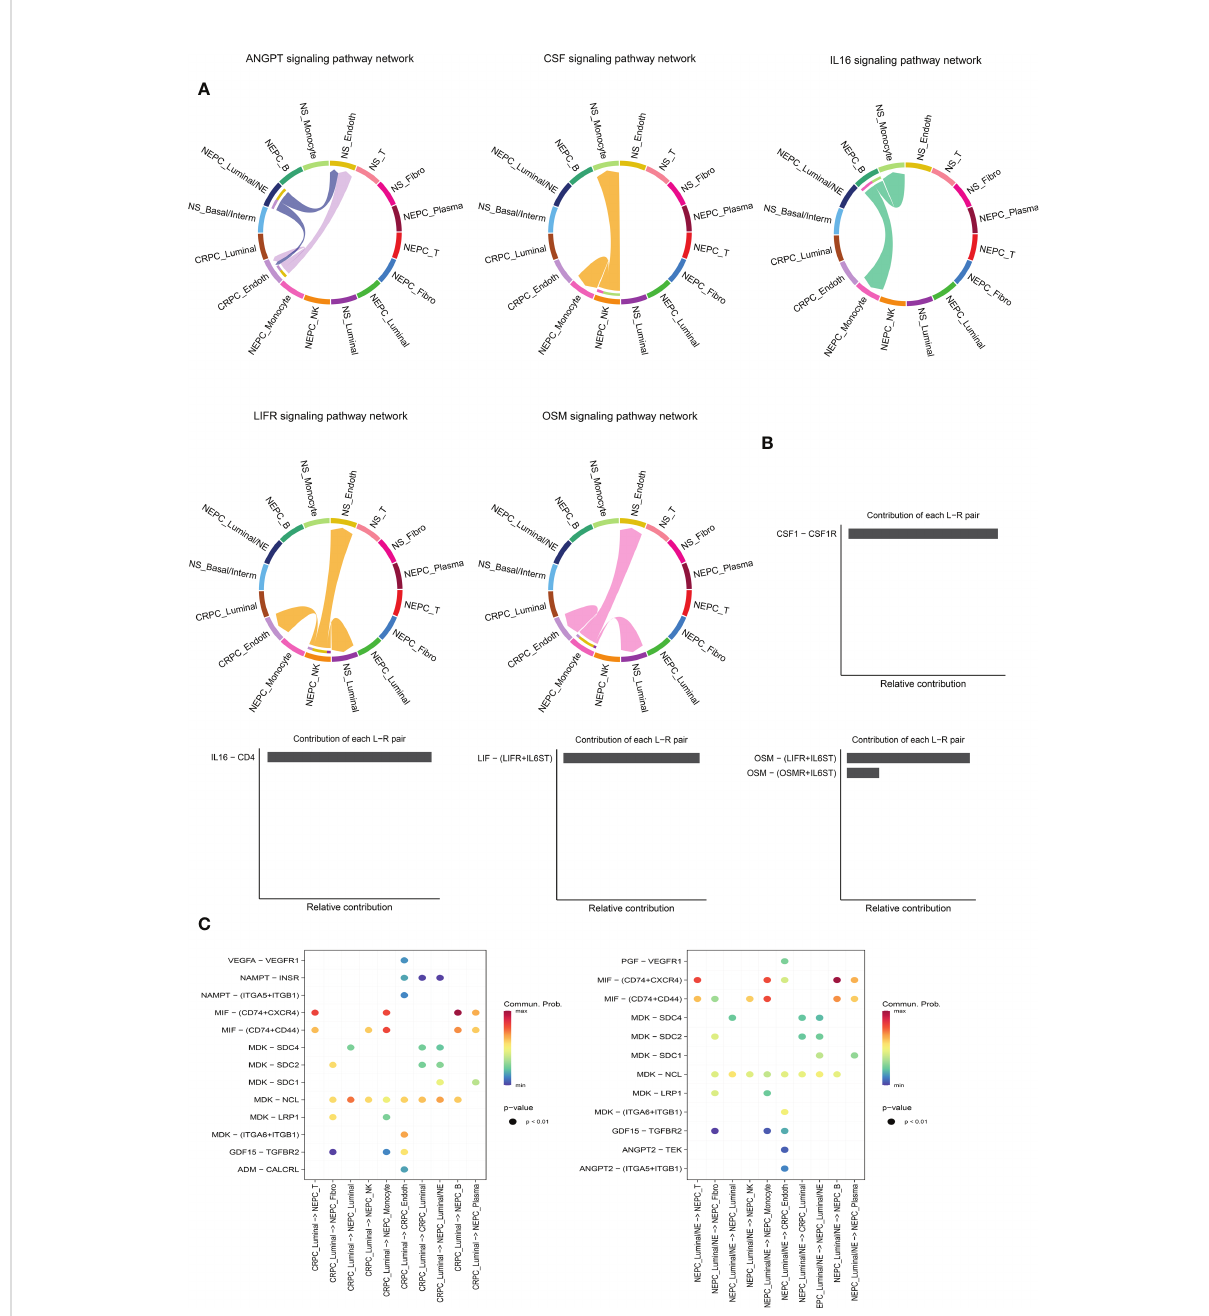
FIGURE 6 Intercellular ligand – receptor prediction among differernt clusters. (A) The chord diagram shows the expression of ANGTP, IL16, CSF, LIFR and OSM pathways among different cell clusters. In the peripheral ring, different colors represent different cells, Cells that send the arrow express the ligand, and cells that the arrow points to express the receptor, the more ligand-receptor pairs, the thicker the line. (B) Relative contribution of each ligand-receptor pair to the signal pathway, which may affect the overall communication network of the signaling pathway. CSF, IL16, LIFR and OSM pathways are shown in turn. (C) The extensive ligand-receptor mediated cellular interaction between different cell clusters of CRPC and NEPC has been further explored and demonstrated. The color gradient indicates the probability of cellular